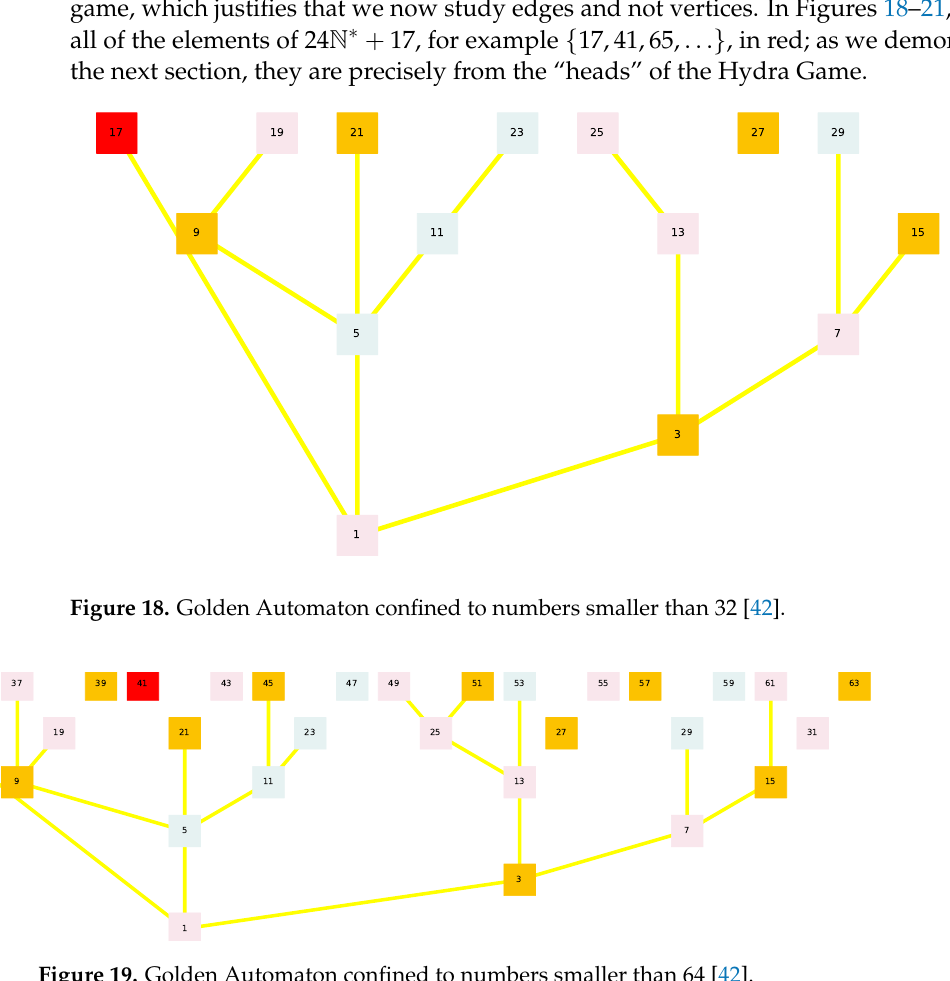
Figure 19. Golden Automaton confined to numbers smaller than 64 [42].